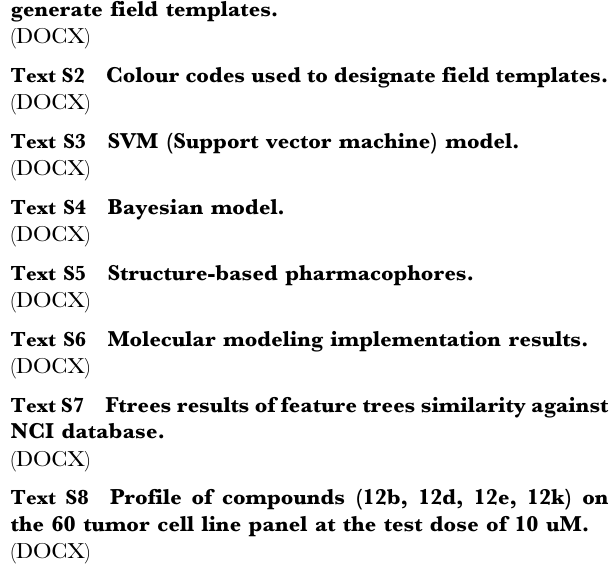
Table S1 Kinase profiling data. Figure S1 Clinically validated cancer